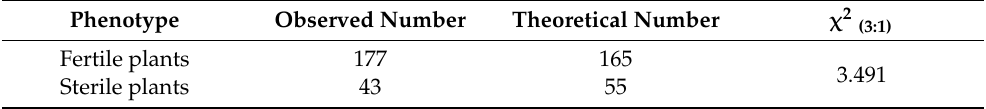
Table 1. Genetic analysis of the fertility separation population in the M 4